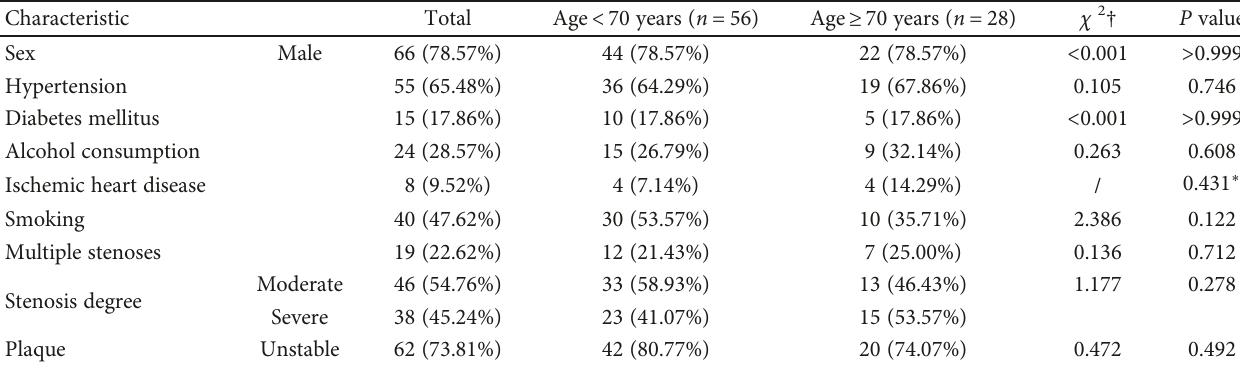
Table 1: Baseline characteristics of patients undergoing carotid artery stenting.